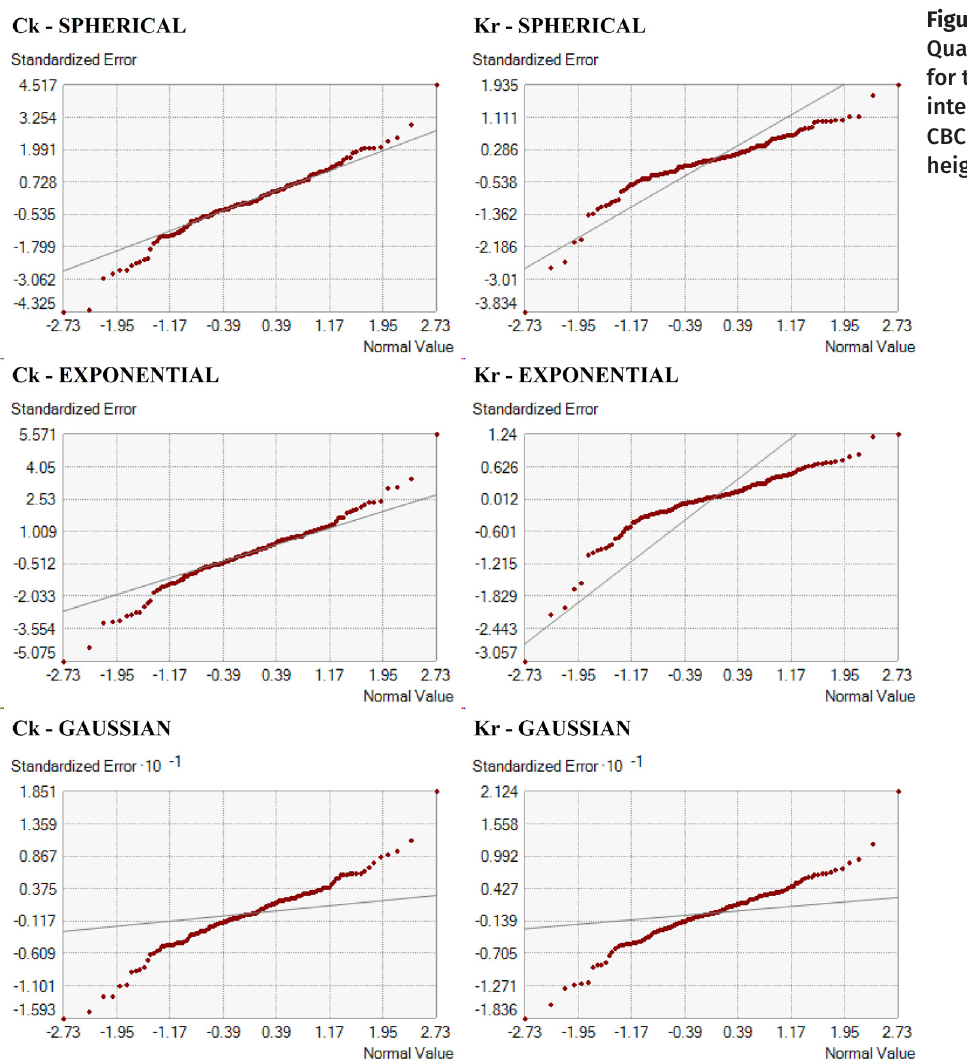
models, RMSSE values are closer to 1, while kriging results show lower RMSSE for spherical and gaussian models, and gaussian cokriging and exponential kriging models show values well above 1, which means that the exponential and spherical cokriging models have a better ability to represent the variability of the dataset.